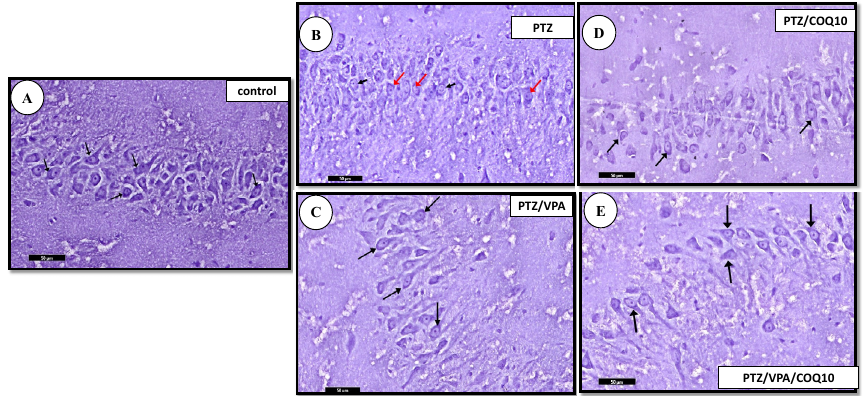
Figure 7. Photomicrographs of the Toluidine blue ‐ stained section of the hippocampus of all of the rat groups. ( A ) Control group showing that the cytoplasm of the pyramidal cells appears heavily studded with Nissl granules ( ↑ ). ( B ) PTZ group showing an apparent decrease in the Nissl granule content (red ↑ ) of the pyramidal cells of the pyramidal layer, compared to that of group I (control, non ‐ epileptic rats). The pyramidal layer with few of the pyramidal cells has large vesicular nuclei (black ↑ ). ( C ) PTZ/VPA group showing an apparent increase in the Nissl granule content ( ↑ ). ( D ) PTZ/COQ10 group showing an apparent moderate increase in the Nissl granule content ( ↑ ) of the pyramidal cells of the pyramidal layer. ( E ) PTZ/VPA/COQ10 group showing an apparent increase in the Nissl granule content ( ↑ ). Toluidine blue; scale bar 50 µ m.